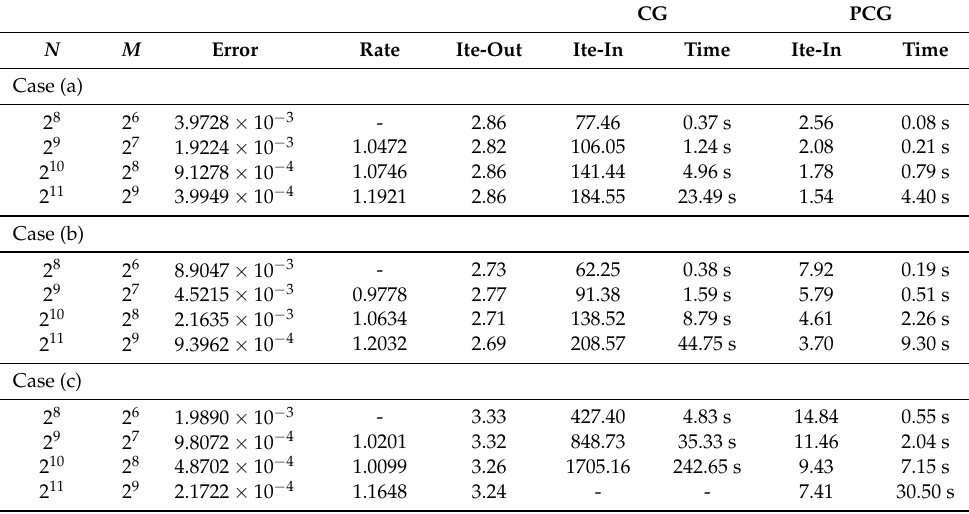
Table 1. Numerical results from the bi-conjugate gradient stabilized methods.